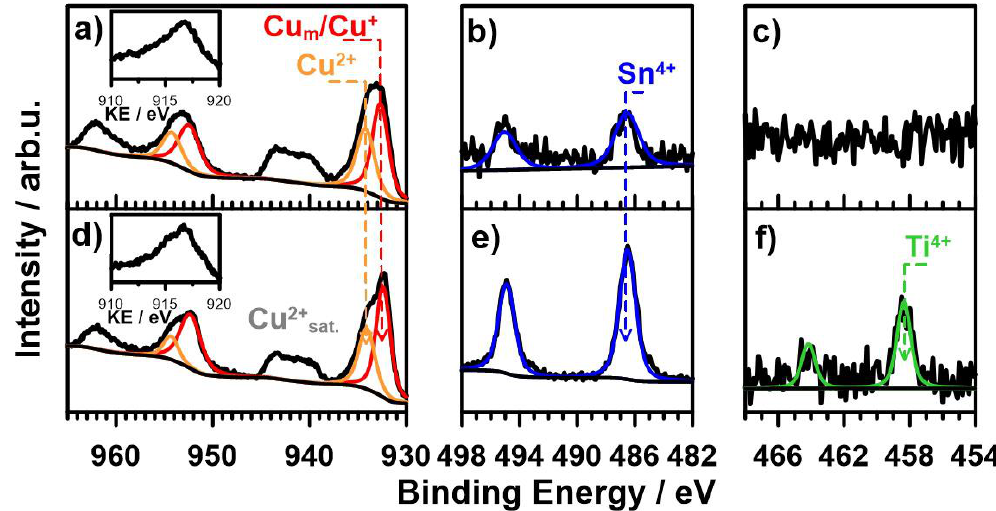
Figure 8. XPS spectra of ( a – c ) Cu – Sn and ( d – f ) Cu – Sn – TiO 2 coatings. High-resolution spectra recorded in the binding energy range of ( a , d ) Cu2p, ( b , e ) Sn3d, and ( c , f ) Ti2p. The inset in ( a ) shows Cu LMM Auger spectra. The XPS data confirmed the presence of Ti 4+ species at the surface of the analyzed Cu – Sn – TiO 2 sample, through the appearance of Ti2p3/2 peak at approx. 458.4 eV.